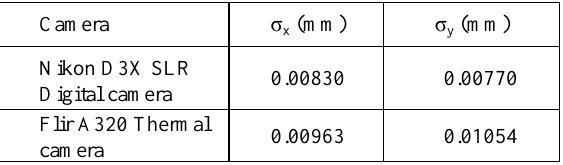
Table 4. The standard deviation of the measured image